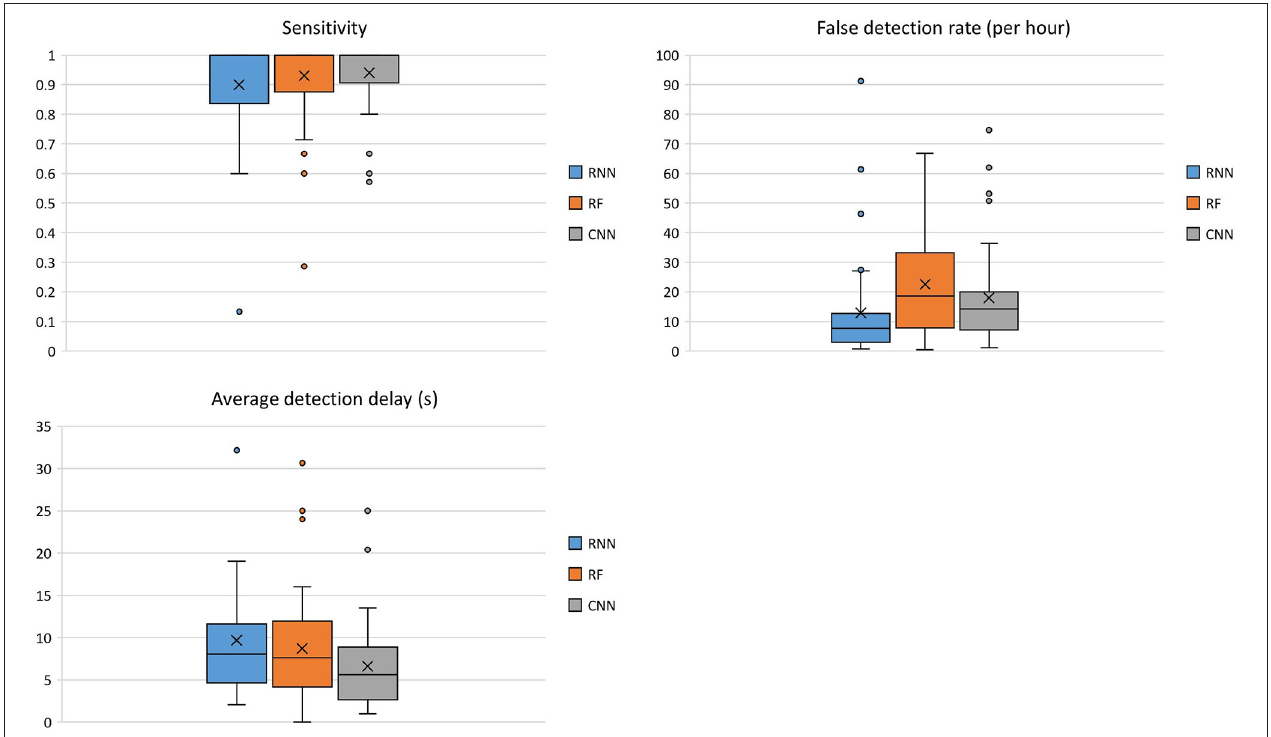
FIGURE 5 | Comparison of the seizure detectors across 40 patients using sensitivity, FDR (per hour), and average detection delay (s) as the performance